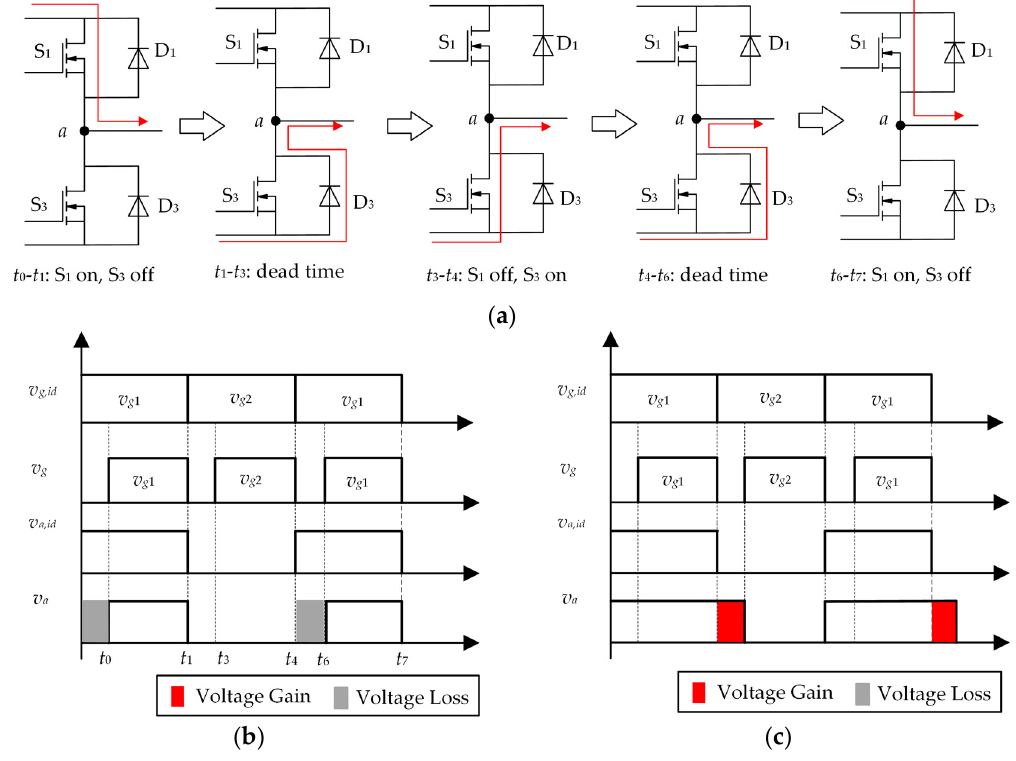
Figure 5. Dead-time effect of hard-switching inverter with single pole ( a ) the operating stages when i o > 0; ( b ) the key waveforms when i o > 0; ( c ) the key waveforms when i o < 0.